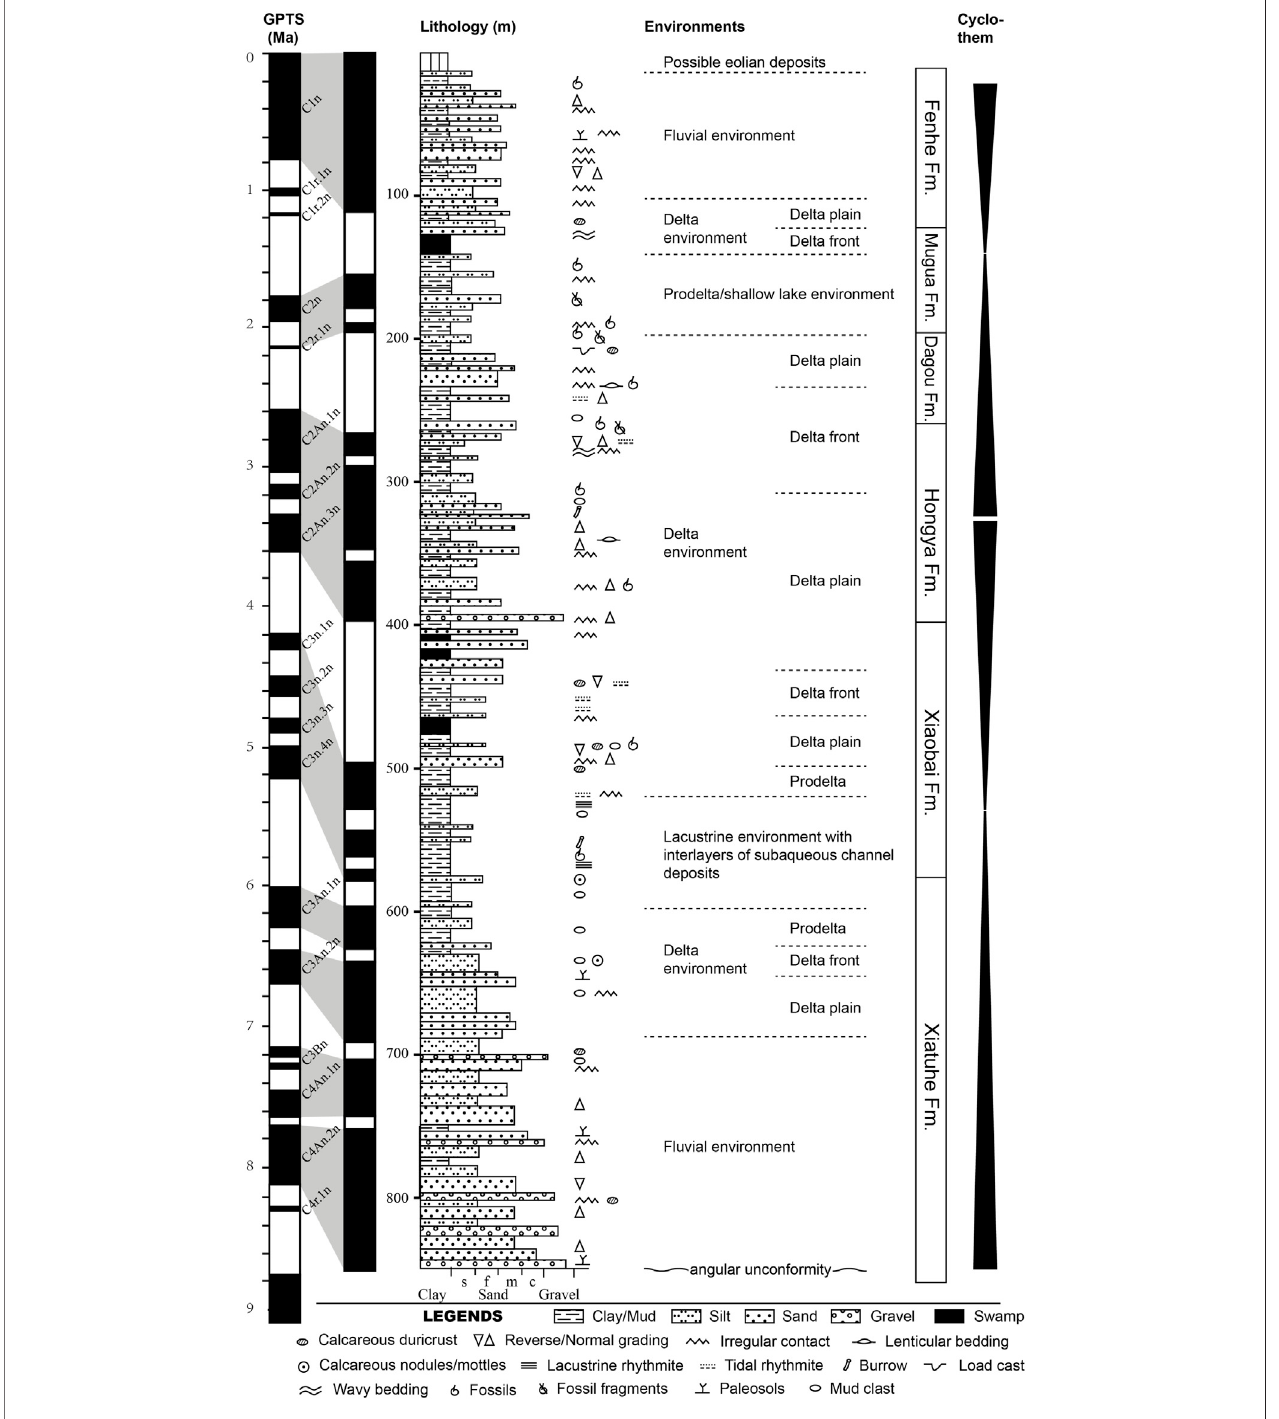
FIGURE 3 | Sedimentary column of ZK01 with time scale (Wei et al., 2020) and sedimentary environments division. Identi fi ed depositional markers are plotted where they were found. A simpli fi ed cyclothem division and detrital maturity are attached as well.